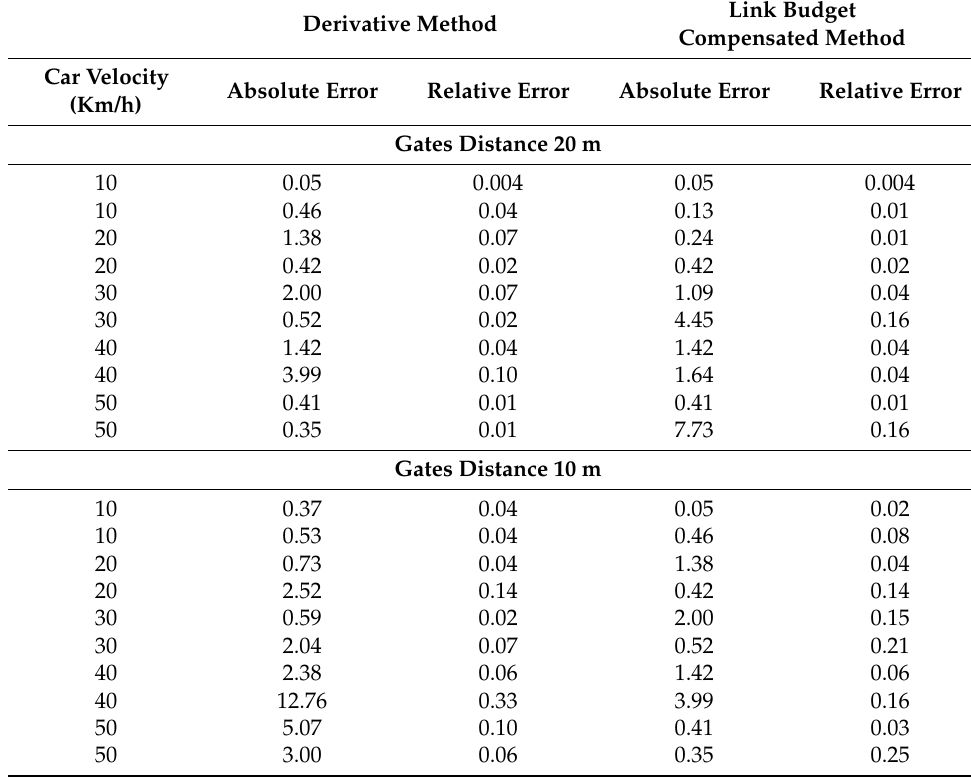
Table 8. Average absolute and relative errors for both car detection